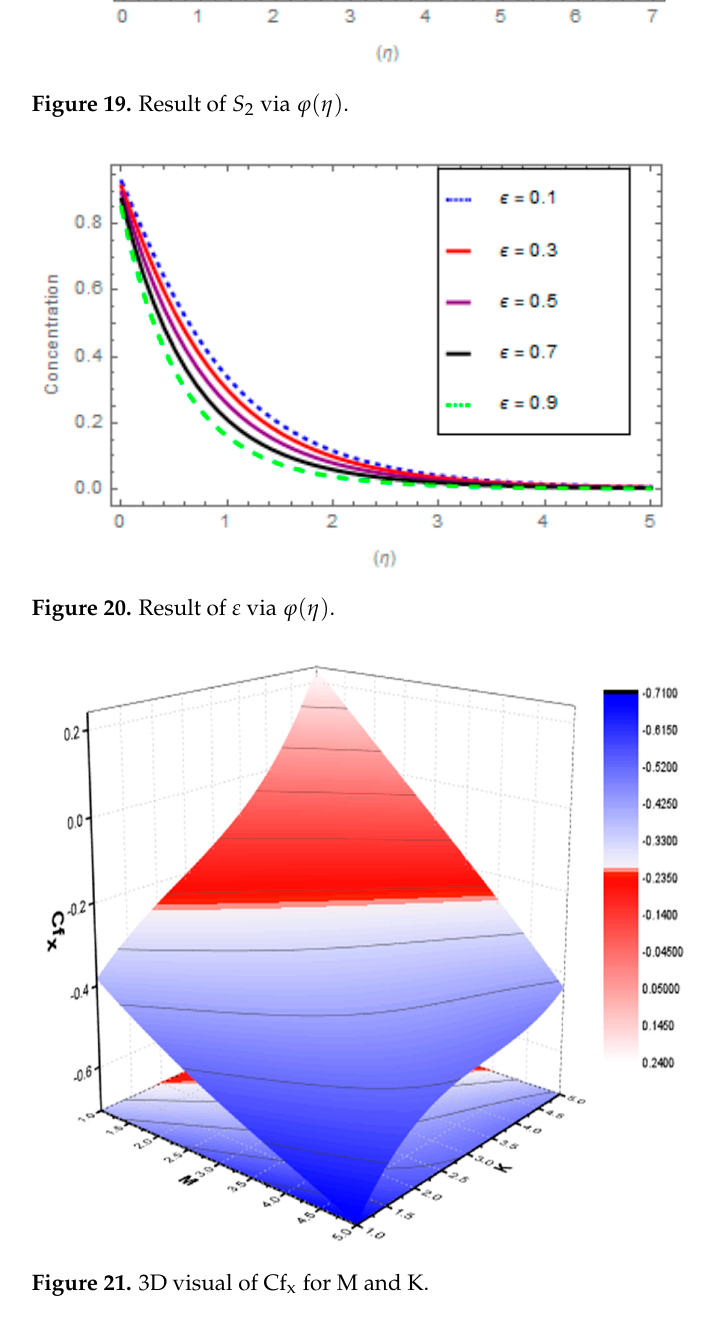
Figure 21. 3D visual of x Cf for M and K .